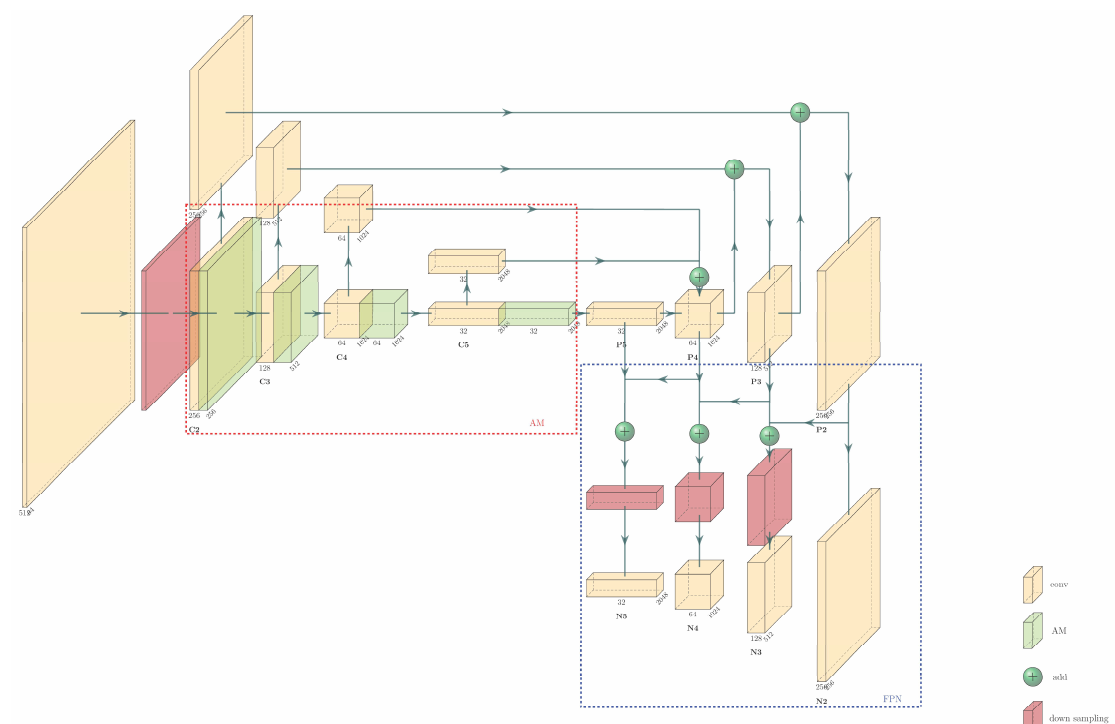
Figure 5. Structure of improved FPN.